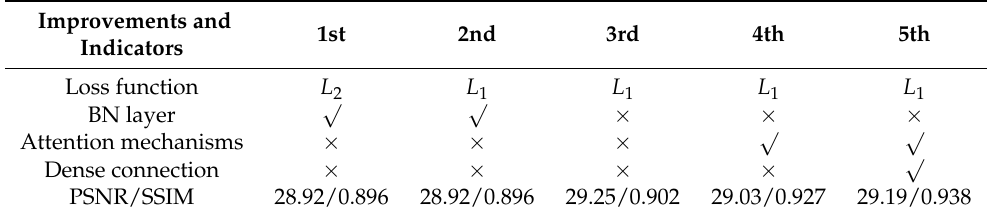
Table 6. Ablation